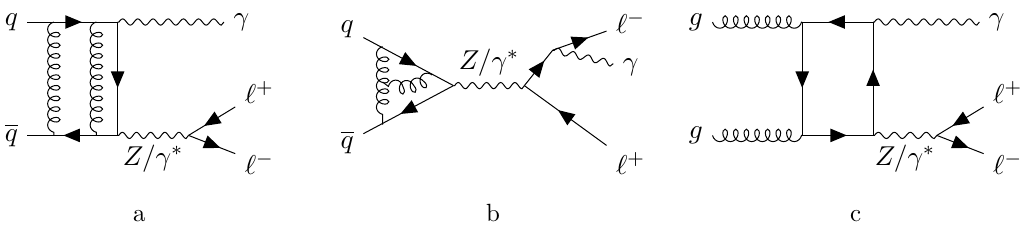
Figure 3. Sample Feynman diagrams entering the ‘ + ‘ − γ process at NNLO: (a) q -type and (b) ‘ -type two-loop diagrams; (c) loop-induced gluon fusion